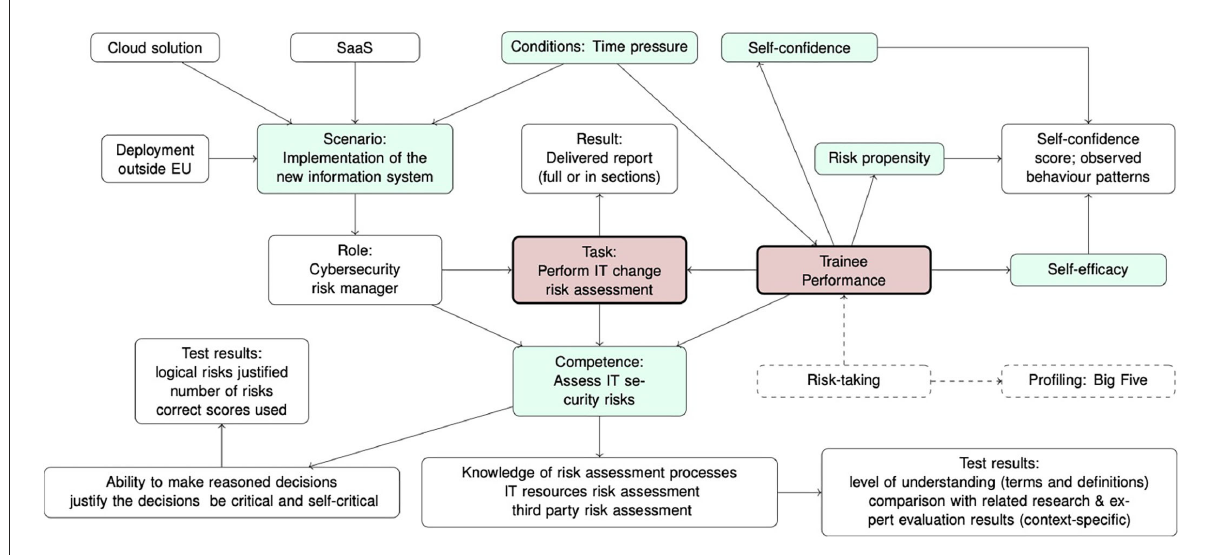
FIGURE2 Illustration of how the model can be applied to develop the competence of risk